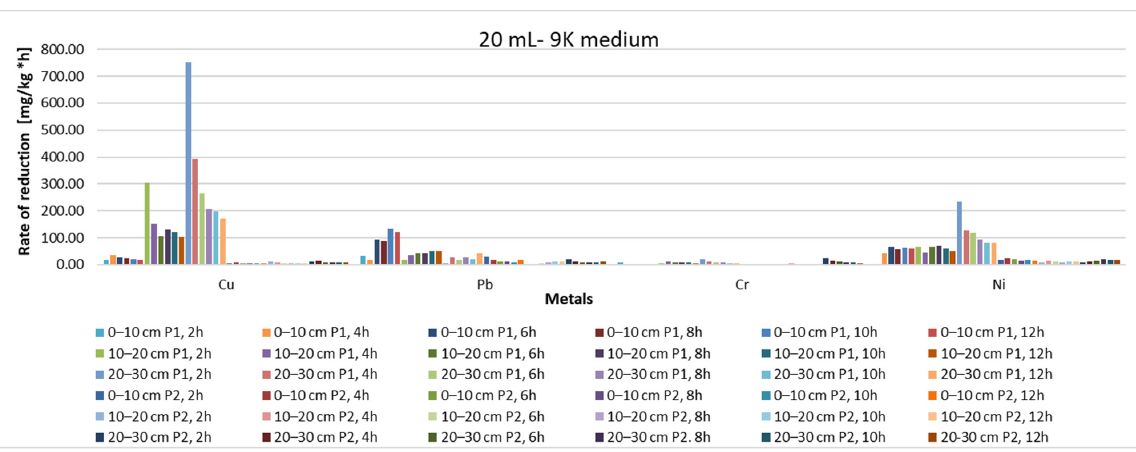
Figure 12. Yield of extraction process with 40 mL of 9K medium.